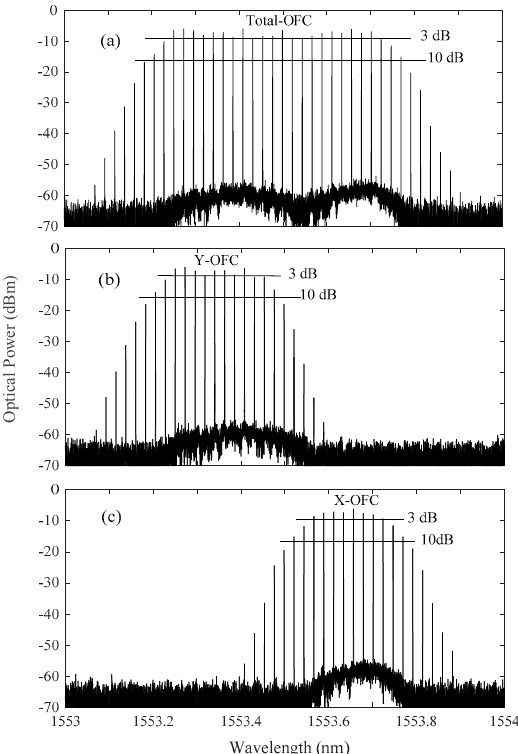
Figure 4. Experimentally measured ( a ) total-OFC, ( b ) Y-OFC, ( c ) X-OFC output from a gain-switching VCSEL under optical injection with injection light wavelength λ i = 1553.4843 nm and injection power P i = 266.80 μ W.